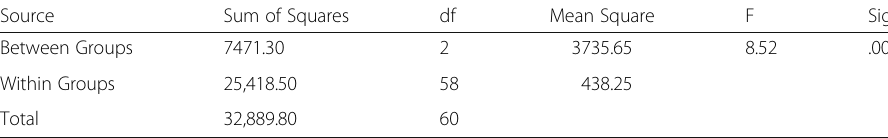
Table 4 ANOVA results for the translation task Source Sum of Squares df Mean Square F Sig. Between Groups Within Groups